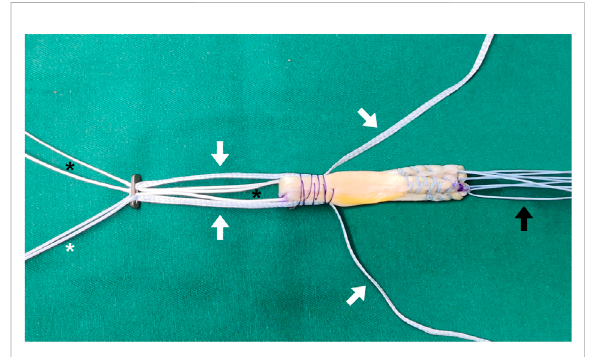
FIGURE 1 The fi nal construct of ST-augmented quadrupled (8-strand) semitendinosus and gracilis tendon autograft, with the ST passing through the femoral button eyelets. White arrow: ST; black arrow: braided nonabsorbable suture; white asterisk: pull suture; black asterisk: adjustable loop suture. ST, suture tape.